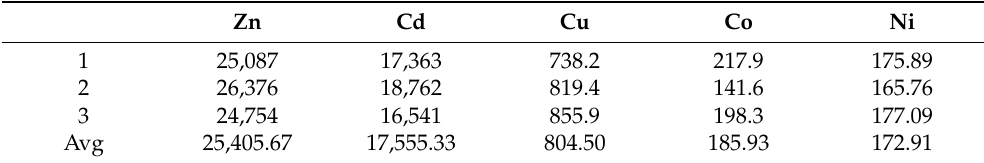
Table 1. The composition of the main metal content of the solution before cadmium extraction in the zinc smelting process (mg L − 1 ). Zn Cd Cu Co